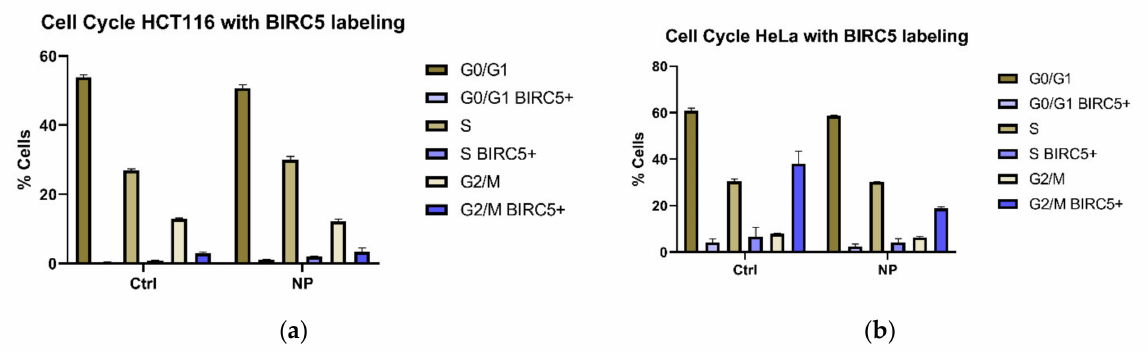
Figure 2. Cell cycle distribution of control and nanocomposite treated cells with BIRC5 labelling. ( a ) Distribution for control and nanocomposite treated HCT116 cells. ( b ) Distribution for control and nanocomposite treated HeLa cells. Analysis for the entire population of cells ( ≥ 50,000 per biological replicate) is shown in the brown bars. Purple colored bars, as indicated in the figure legend, apply to BIRC5 positive cells: the most intensely stained ~1000 cells in each case. Each bar represents the average and standard deviation from triplicate experiments; for gating strategy, see Figure S3; for cell numbers, BIRC5 staining intensity, and other details, see Table